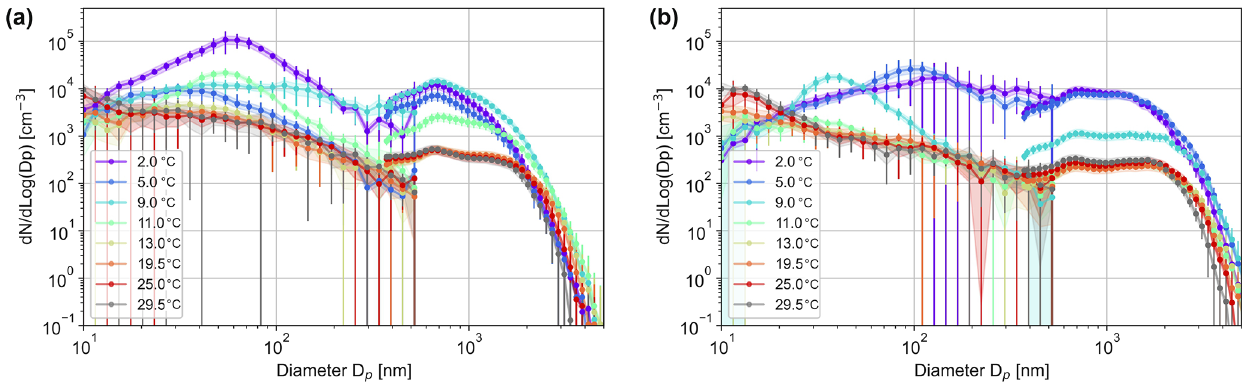
Figure 9. Temperature-dependent aerosol size distributions for Baltic (a) and Mediterranean (b) seawater bubbled at 0.8Lmin − 1 , measured with DMPS (circles) and APS